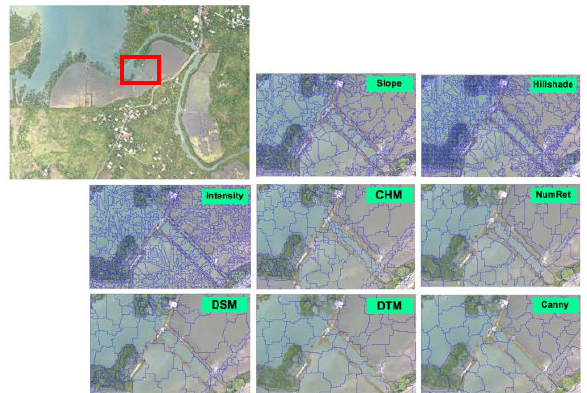
Figure 2. Segmentation results for each LiDAR derivative